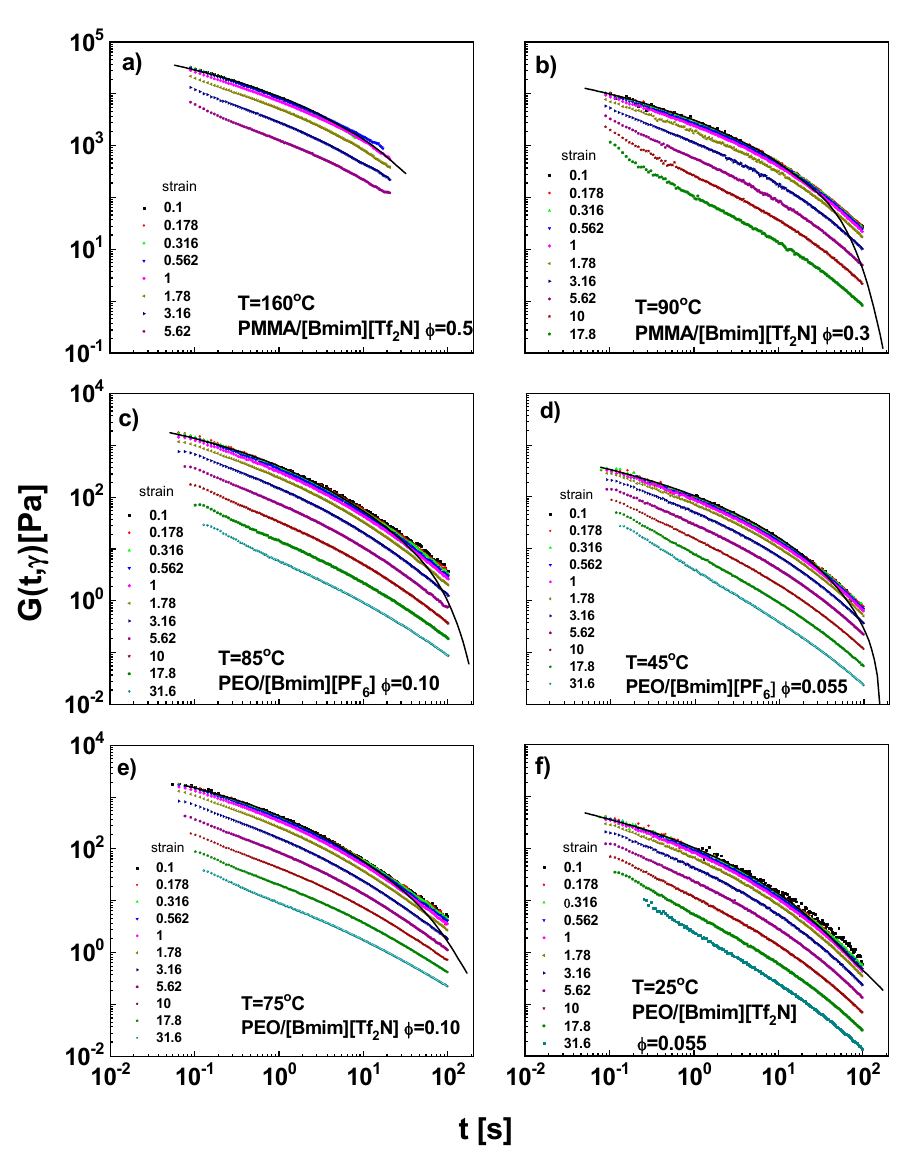
Figure 5. The stress relaxation moduli for ( a ) PMMA/[Bmim][Tf 2 N], ϕ = 0.5, 160 °C , ( b ) PMMA/[Bmim][Tf 2 N], ϕ = 0.3, 90 °C , (c) PEO/[Bmim][PF 6 ], ϕ = 0.10, 85 °C , (d) PEO/[Bmim][PF 6 ], ϕ = 0.055, 45 °C, (e) PEO/[Bmim][Tf 2 N], ϕ = 0.10, 75 °C , and (f) PEO/[Bmim][Tf 2 N], ϕ = 0.055, 25 °C . The solid curves are the G ( t , γ ) when γ → 0, converted from master curves.